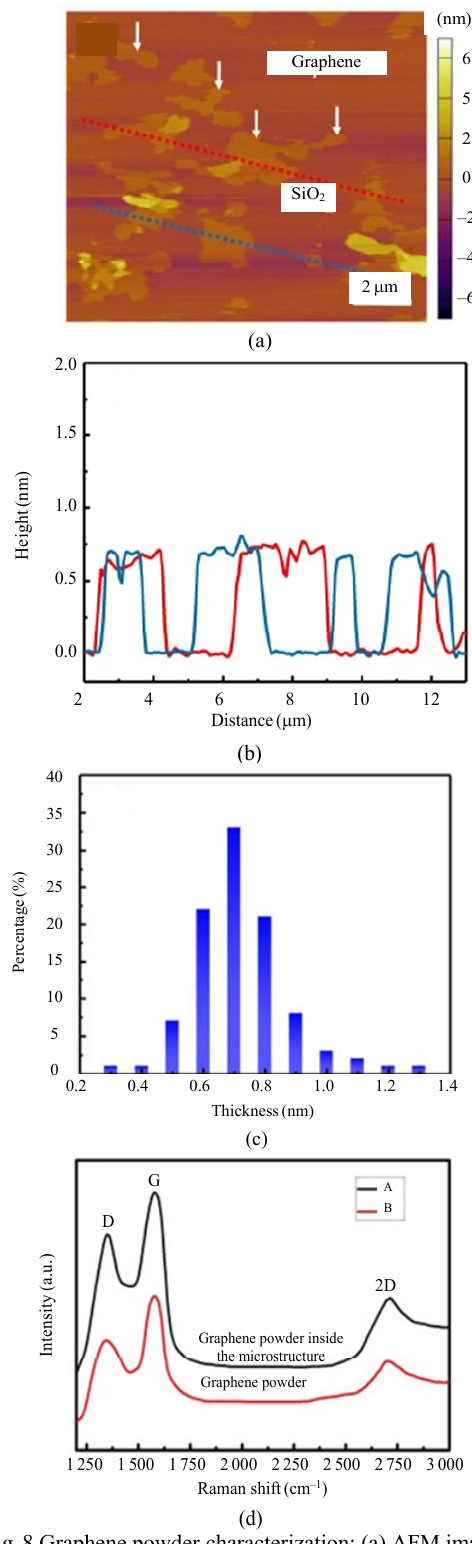
(d) Fig. 8 Graphene powder characterization: (a) AFM images of graphene powder, (b) thickness profile along the line in (a), (c) flake thickness distribution of graphene powder, and (d) graphene and assembled graphene Raman